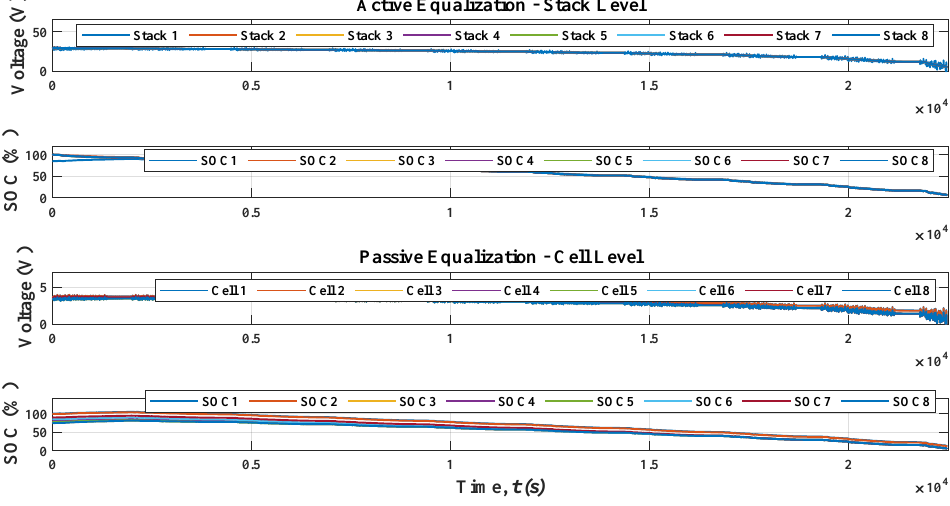
Figure 14. Simulation results of the EV model. Details of voltage and SOC behavior of passive equalization at stack and cell